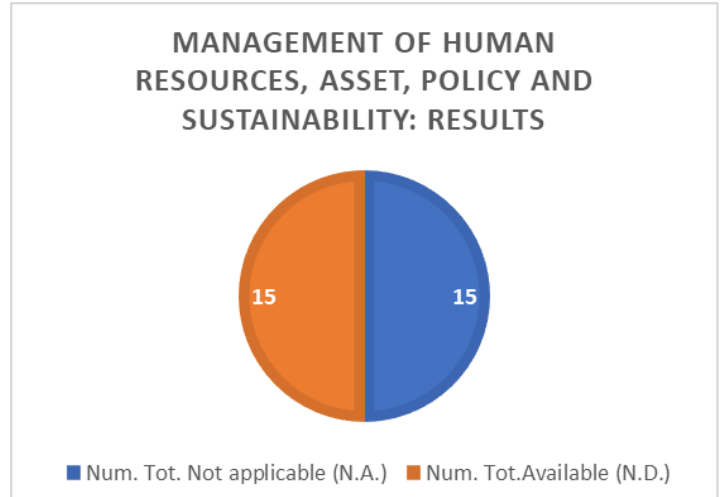
Figure 6. Results of the “Management of Human Resources, Assets, Policy, and Sustainability”